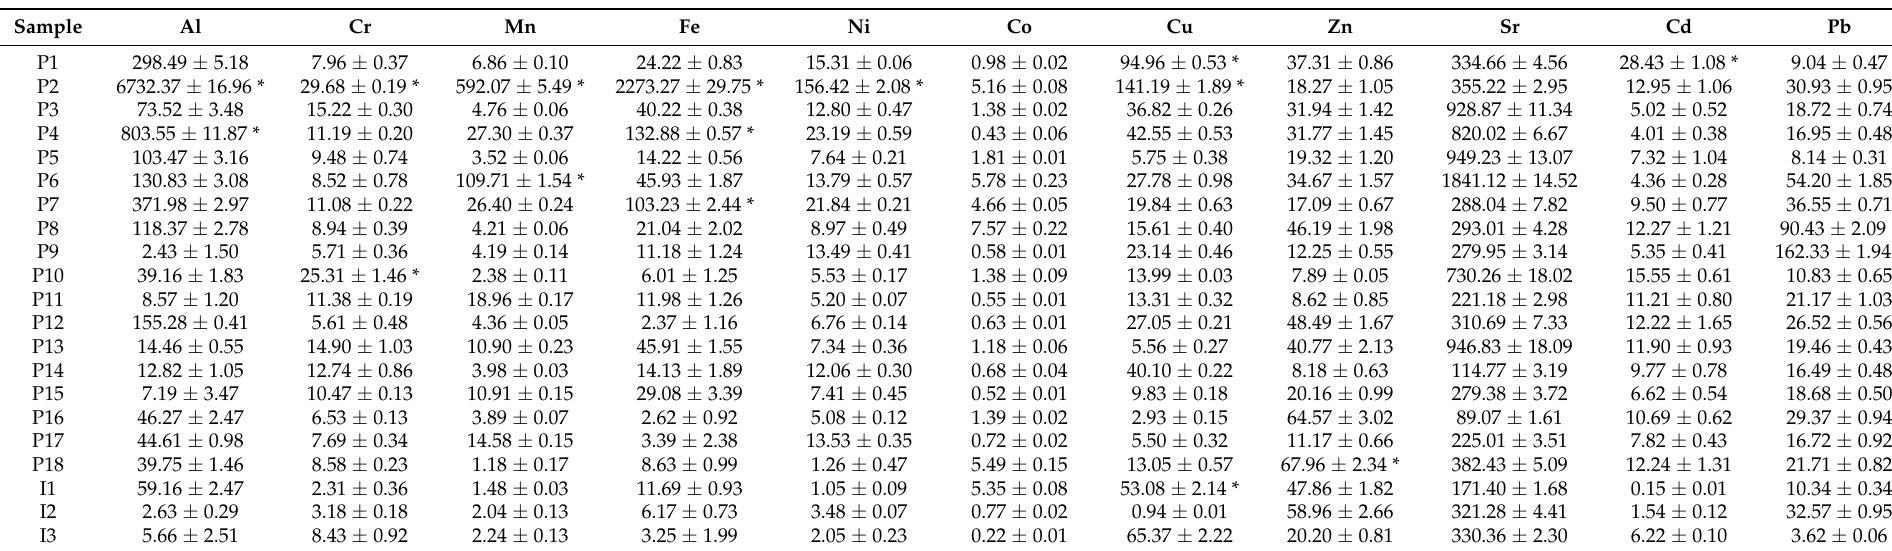
Table 5. Mean concentration of metals (expressed as µ g/L ± S.D.) in freshwaters (wells and springs) from the Banat mining